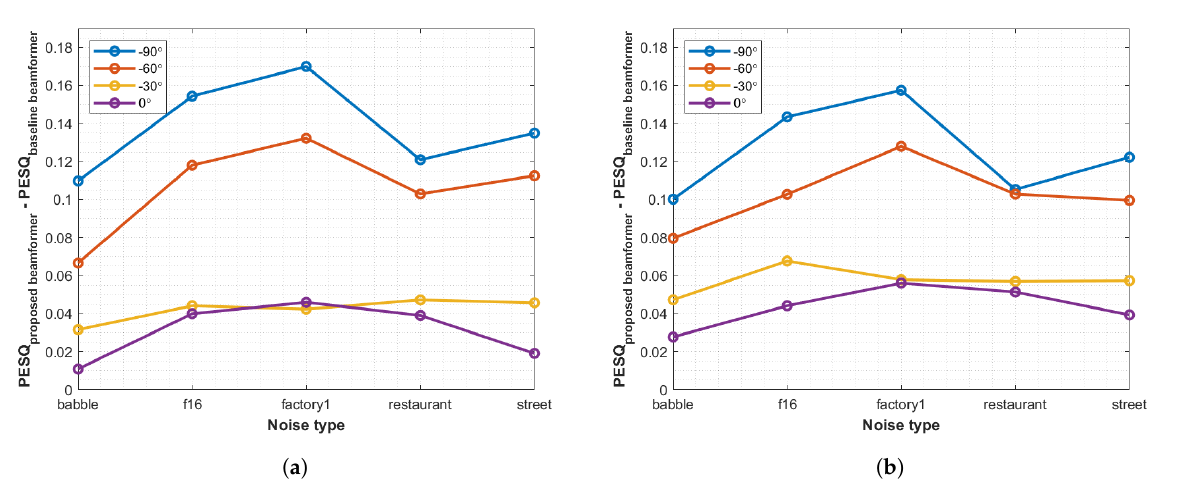
Figure 6. Difference of the average PESQ scores for the proposed and baseline beamformers in diffuse noise environments for five noise types with the RT60s of ( a ) 300 ms and ( b ) 500